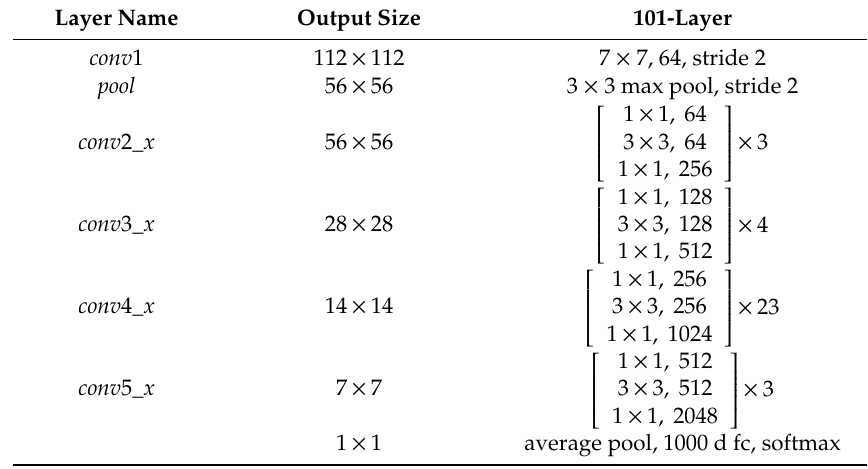
Table 1. Architecture of the ResNet101.